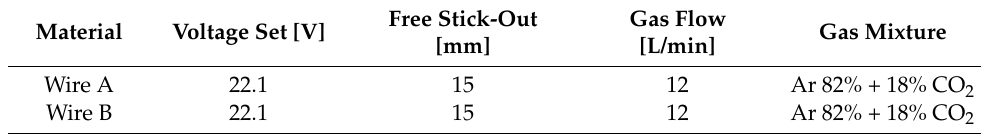
Table 4. Values kept constant during all experimental